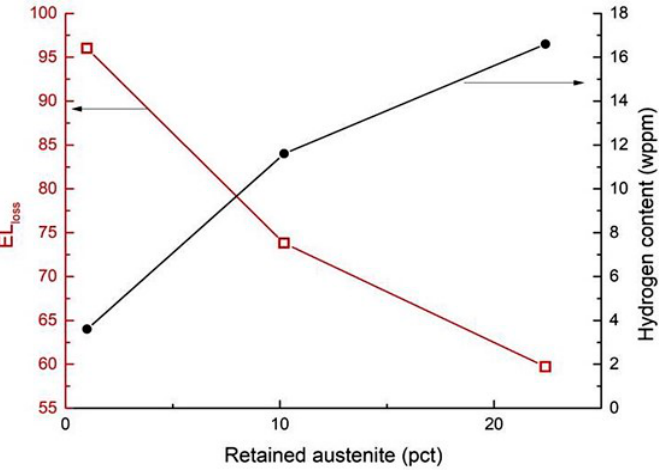
Figure 6. HE index, represented by elongation loss (EL loss ) due to H, and H concentration as a function of the volume fraction of retained austenite in a medium-Mn steel (Fe–0.065C–0.2Si–5.45–Mn, in wt pct). Figure reproduced from Reference [43], with permission from Elsevier.